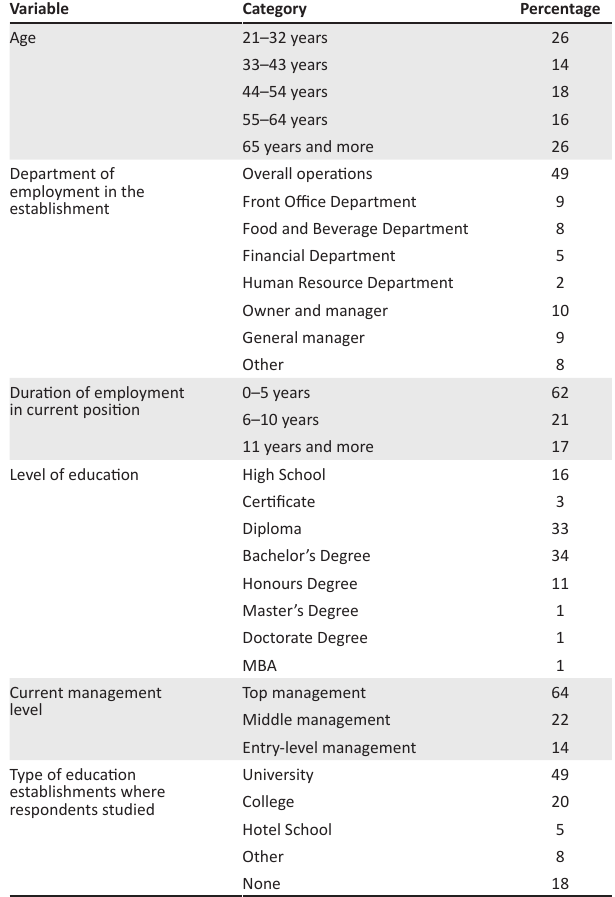
TABLE 2: Population ( N ), expected sample size ( s ) and actual sample size ( S ). Province